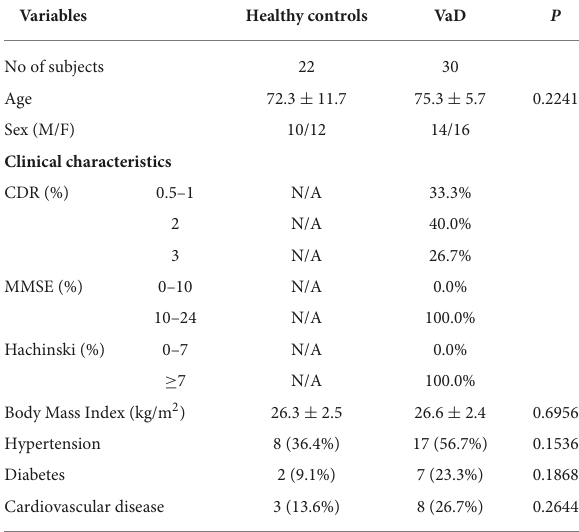
TABLE 2 The demographic and identity of clinical